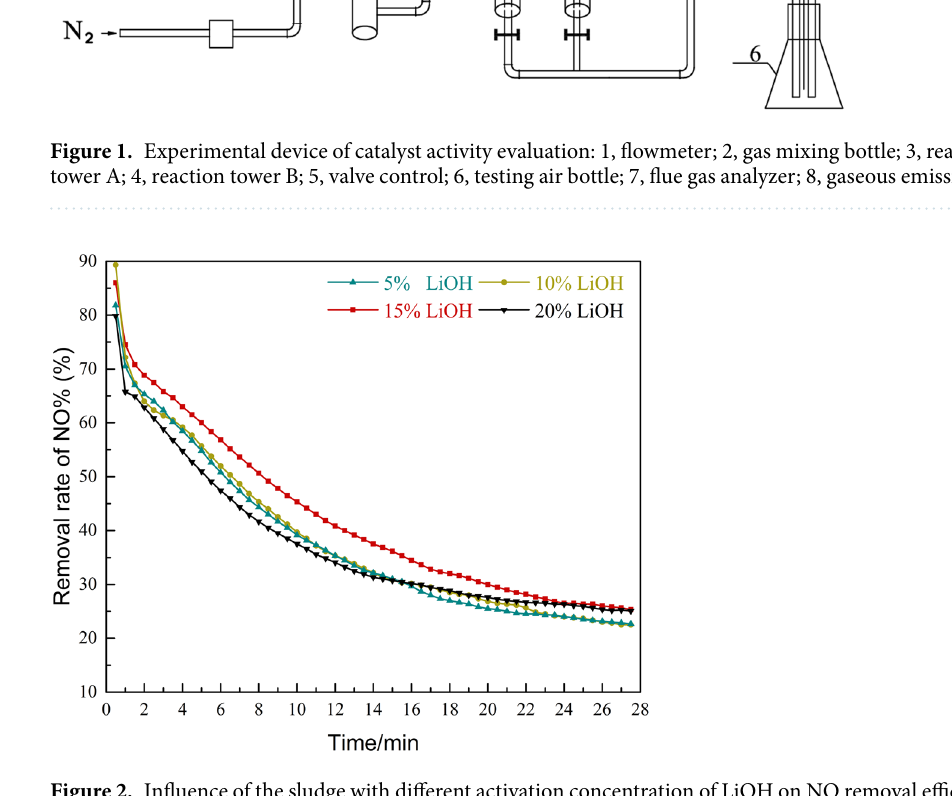
Figure 2. Influence of the sludge with different activation concentration of LiOH on NO removal